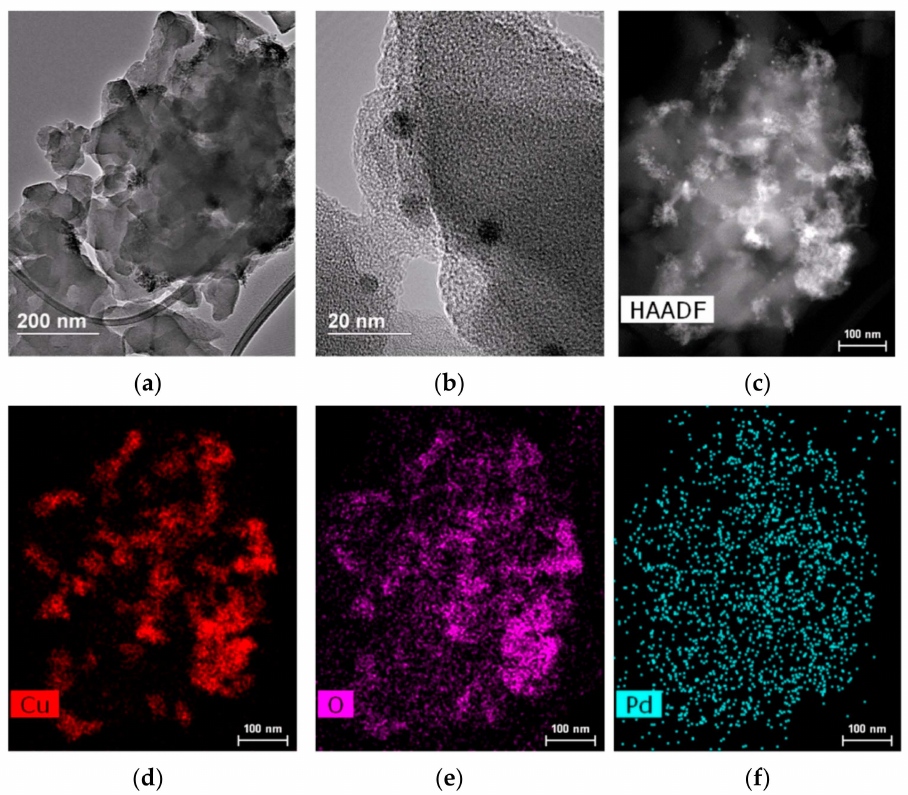
Figure 3. Bright-field ( a , b ) and dark-field ( c ) STEM images of the initial (unreduced) sample 1%- PdCu/HPS and EDX mapping of Cu ( d ), O ( e ), and Pd ( f ).